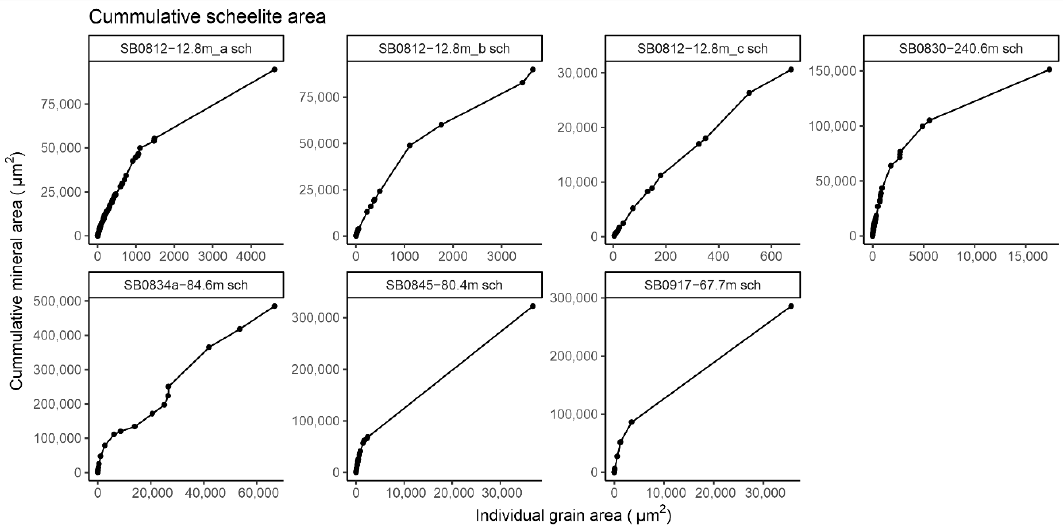
Figure 7. Cumulative grain area of scheelite in measured samples. Note that larger grain size fractions account for the bulk of the mineralization area.